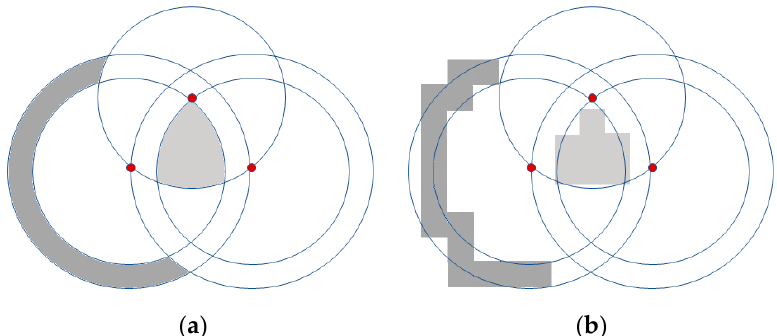
Figure 4. Example of the regionalization using the grid scan method . ( a ) Ideal region; ( b ) method grid scan with low granularity.